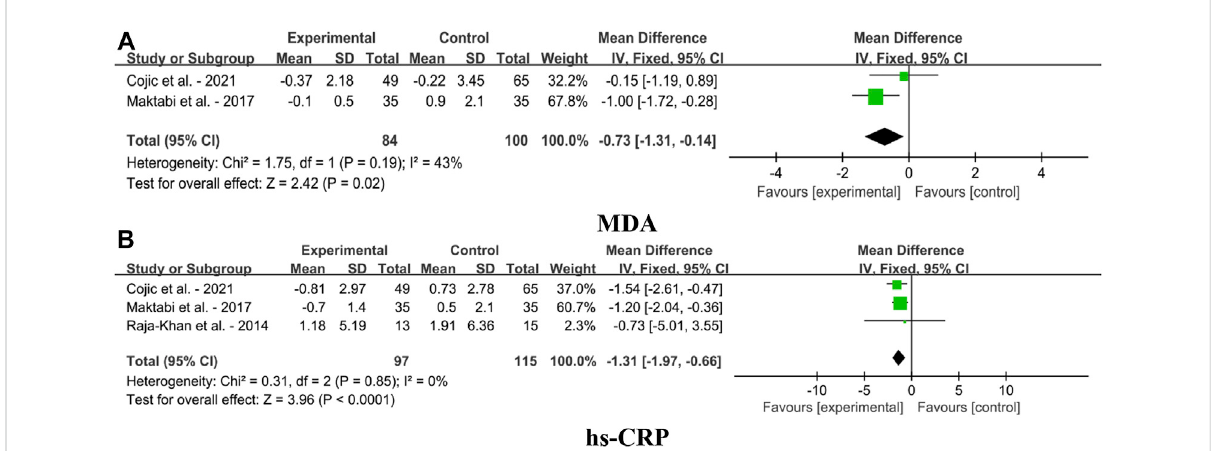
FIGURE 7 Forest plots for the effects of VDS on oxidative stress parameters in MetS adults. (A) MDA: malondialdehyde, (B) hs-CRP: hypersensitive C-reactive protein. The horizontal bar indicates the 95% con fi dence interval (CI). The size of the rectangle at the center of the horizontal bar is proportional to the weight of the given study. The diamond at the bottom indicates the pooled mean difference (MD).